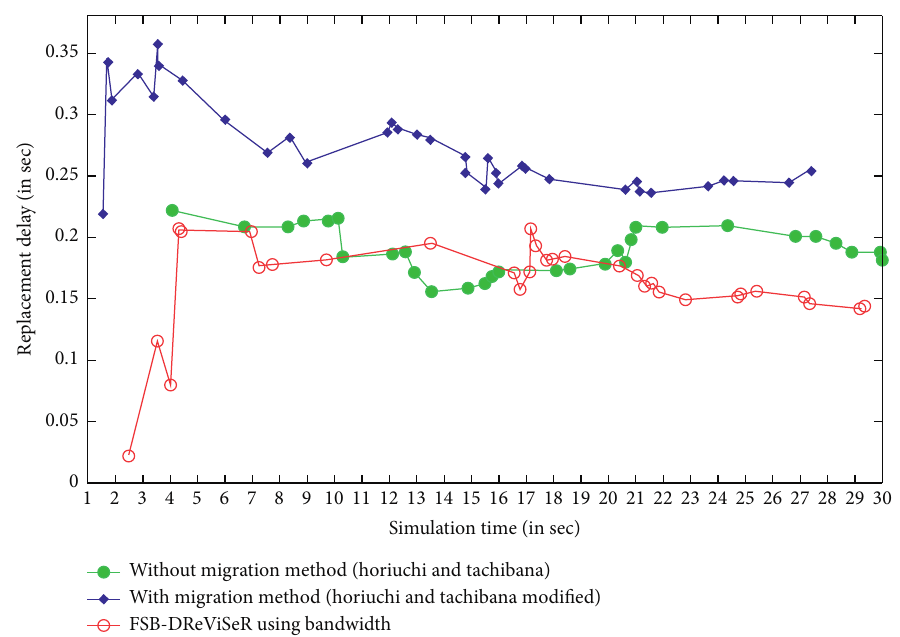
Figure 10: Replacement delays for a 20-node